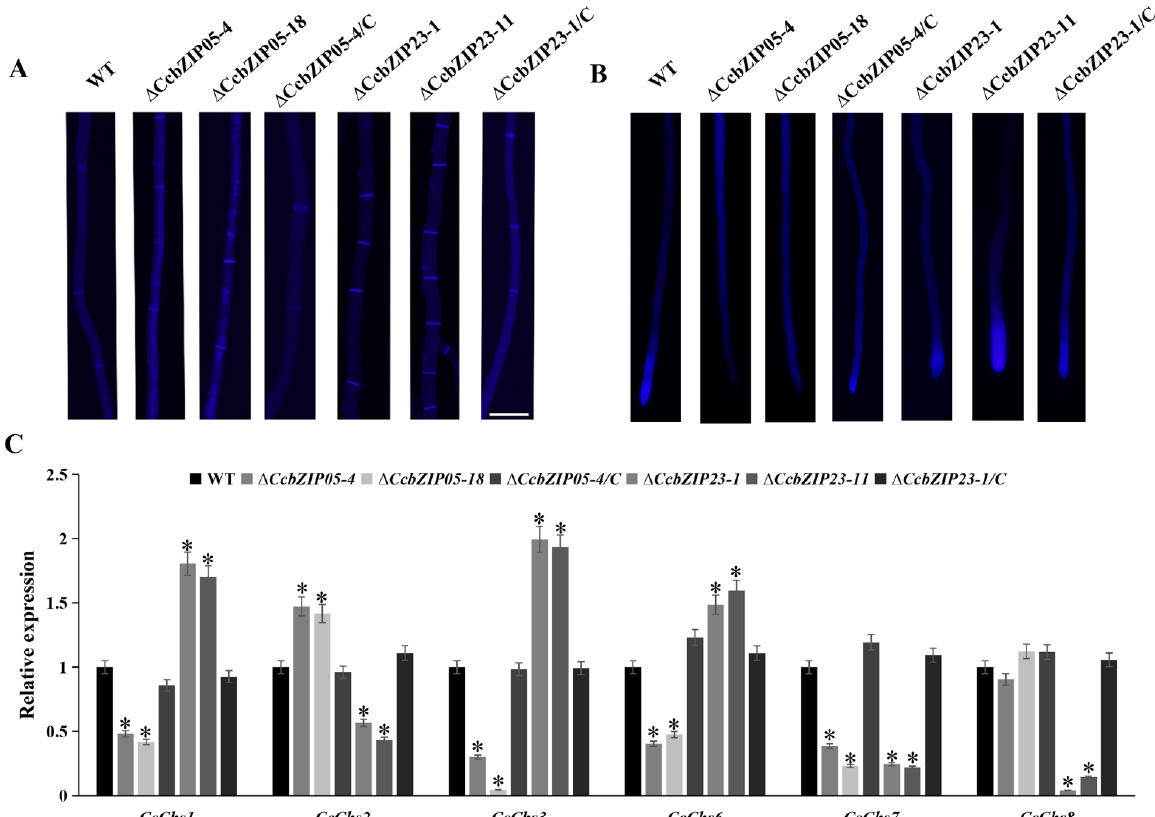
Figure 8. Chitin deposition and the expression of the putative chitin synthase-encoding genes in each strain. ( A ) Differences in the number of septa in mycelia. Bar = 50 μ m. ( B ) Chitin deposition on hyphal tip. ( C ) Expression of chitin synthase-encoding genes in wild-type and deficient mutants. The qRT-PCR was used to measure the expression of chitin synthase-encoding genes in the wild- type, Δ CcbZIP05 and Δ CcbZIP23 mutants, and complemented strains. The CcActin gene was used as the reference gene. The experiments were repeated three times. The data were analyzed using one way ANOVA and Duncan’s range test. The asterisks indicate significant differences ( p < 0.05).